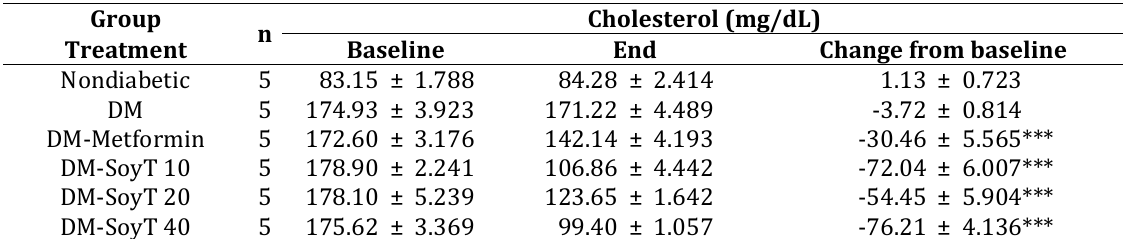
Table III. Cholesterol levels after 3 weeks of treatment Group